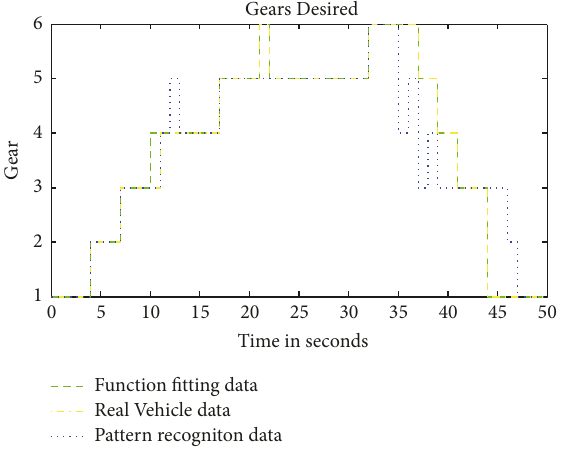
Figure 26: Gear timing of road test 6.